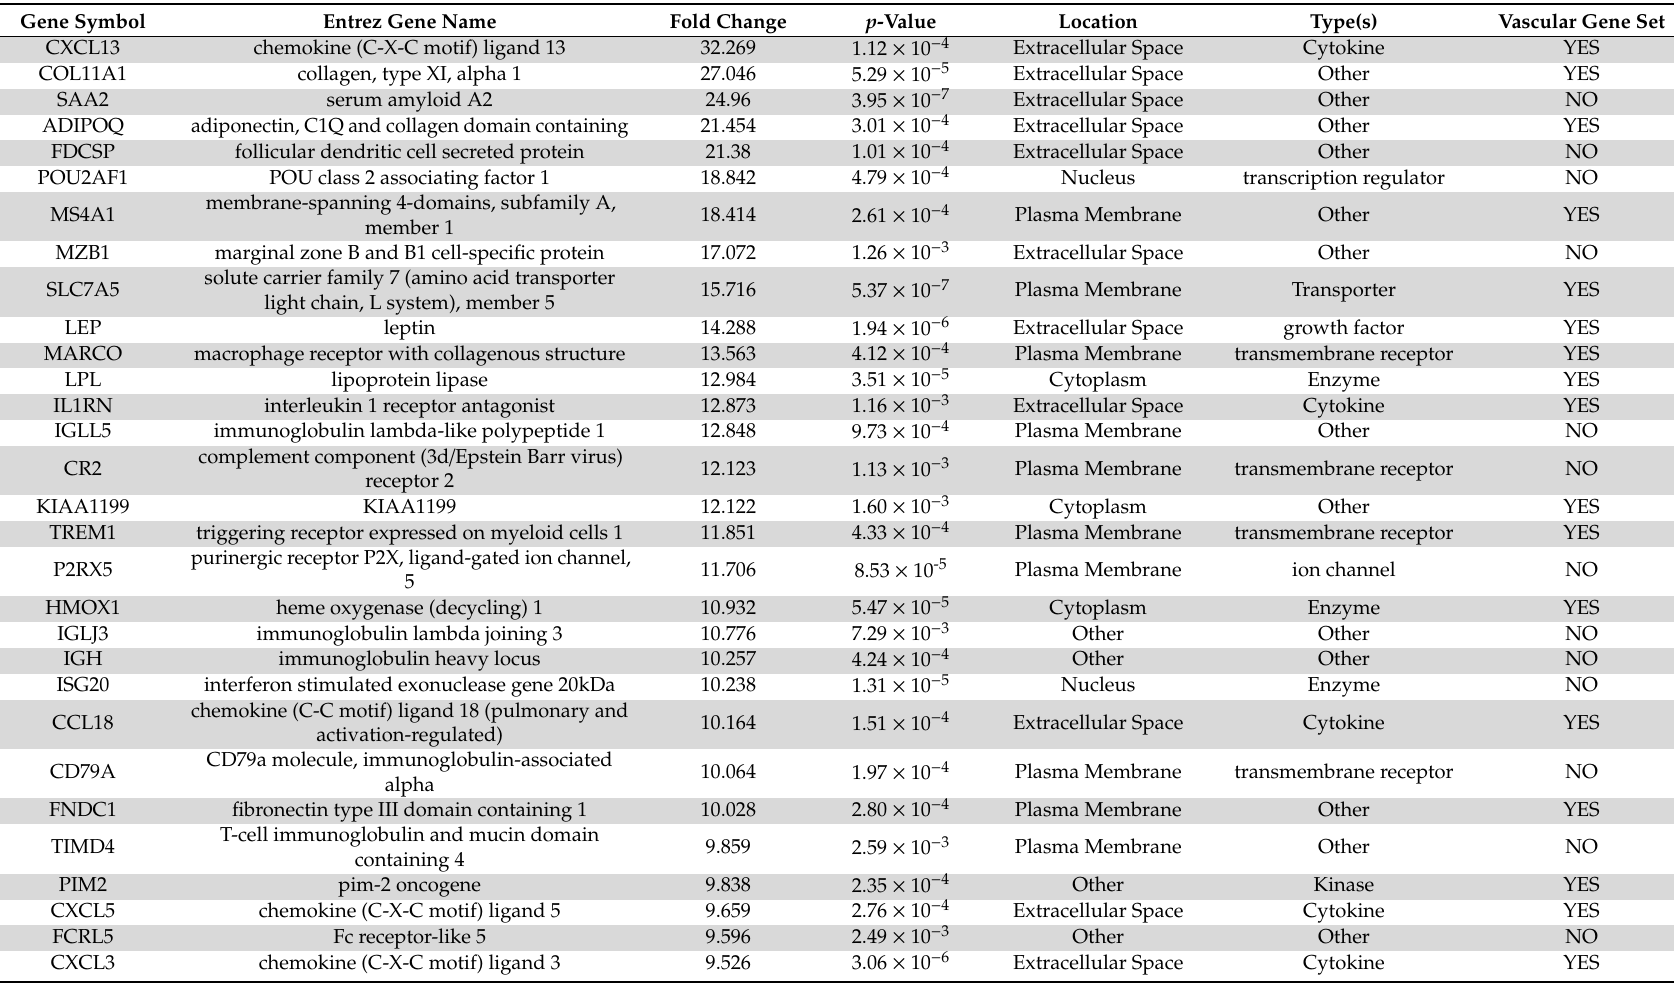
Table 3. Top 30 upregulated genes (AAA gene list, part 1) in AAA versus AOD, including fold change (FC), p -value, location in the cell (location), type of molecule, and presence in the vascular gene